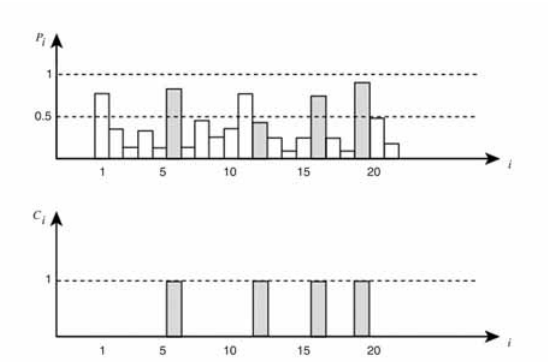
Fig. 1. Probability of occurrence for seismic events in non overlapping sub-volumes i = 1,…, N , estimated by a forecasting model (top), and realisation of the process observed in the same sub-volumes (bottom) (after Console,